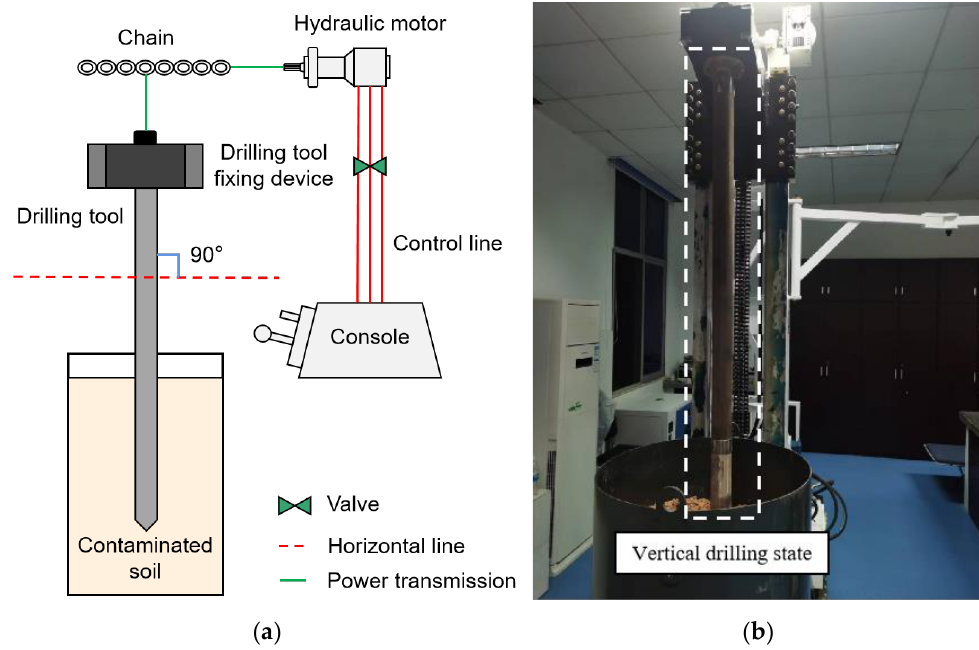
9 of 16 Figure 7. Simulated contaminated soil layer. Table 2. Physical parameters of the clay (Data from [36,37]). Properties